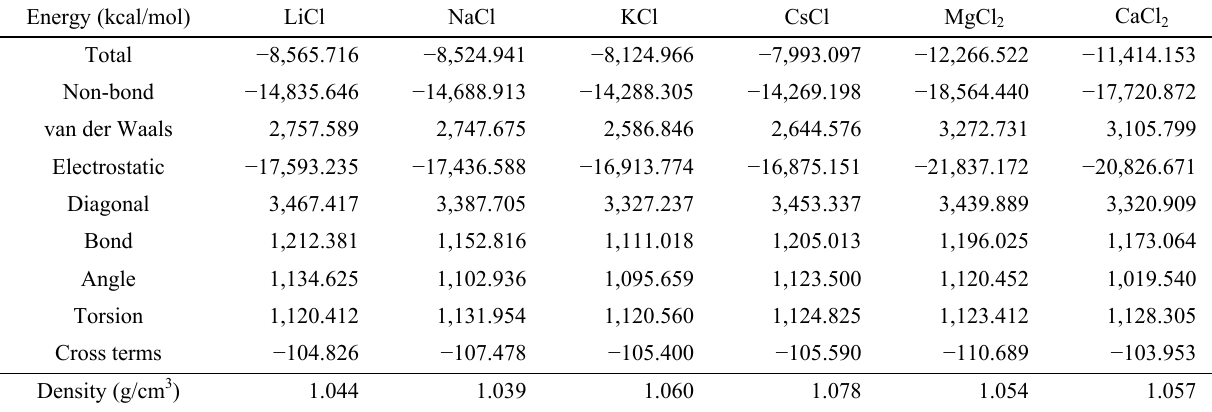
Fig. 9 Changes in temperature and energy of different unit cells over time: (a) temperature–time fluctuation diagram of different unit cells; (b) energy–time fluctuation diagram of different unit cells. Table 3 Unit cell energy and its composition after kinetic